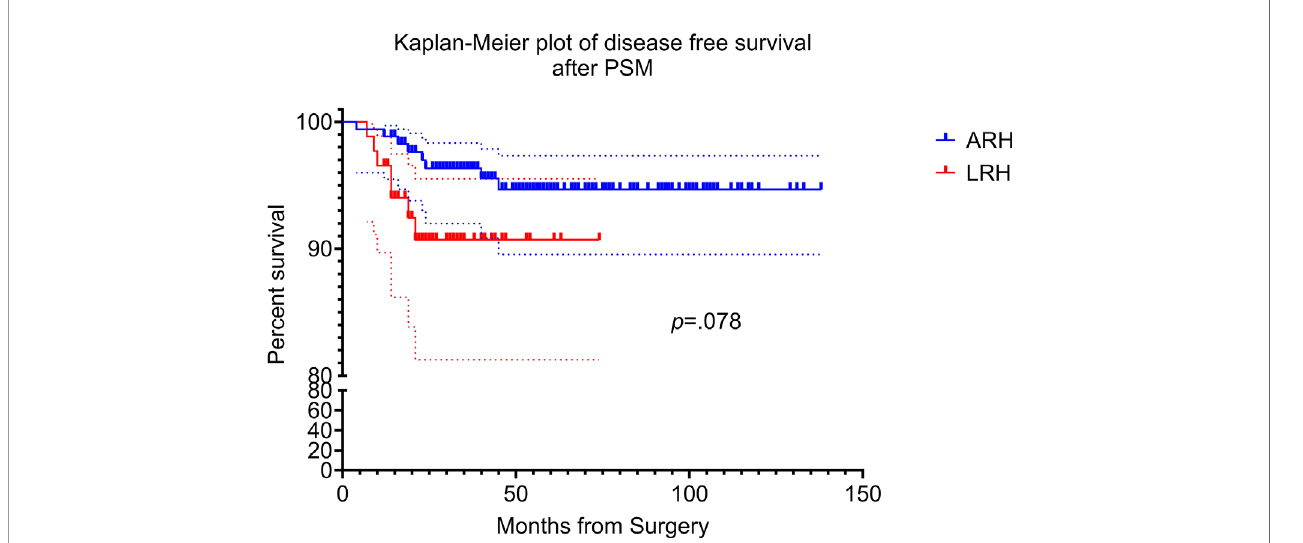
FIGURE 2 | Kaplan – Meier disease free survival curves for laparoscopic radical hysterectomy and abdominal radical hysterectomy. The disease-free survival (DFS) rate of ARH and LRH after propensity score